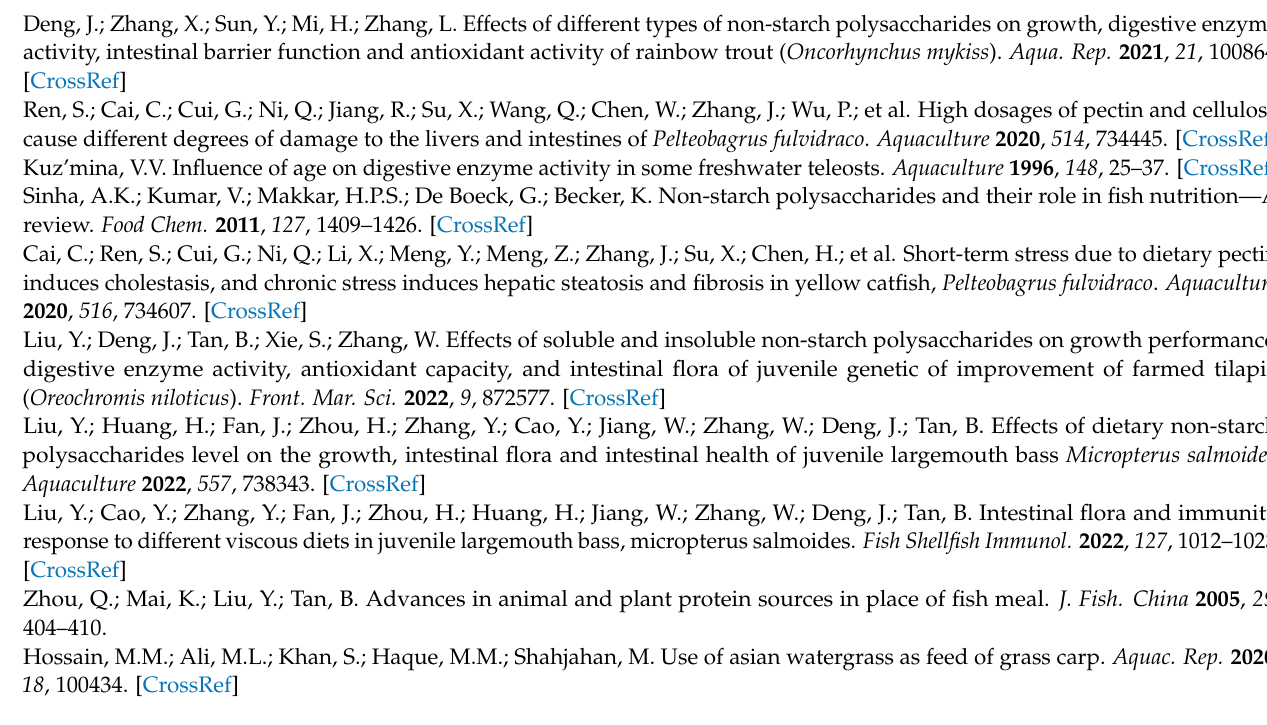
phase elution procedure, Table S4: Differential metabolites between FM and INSP groups, Table